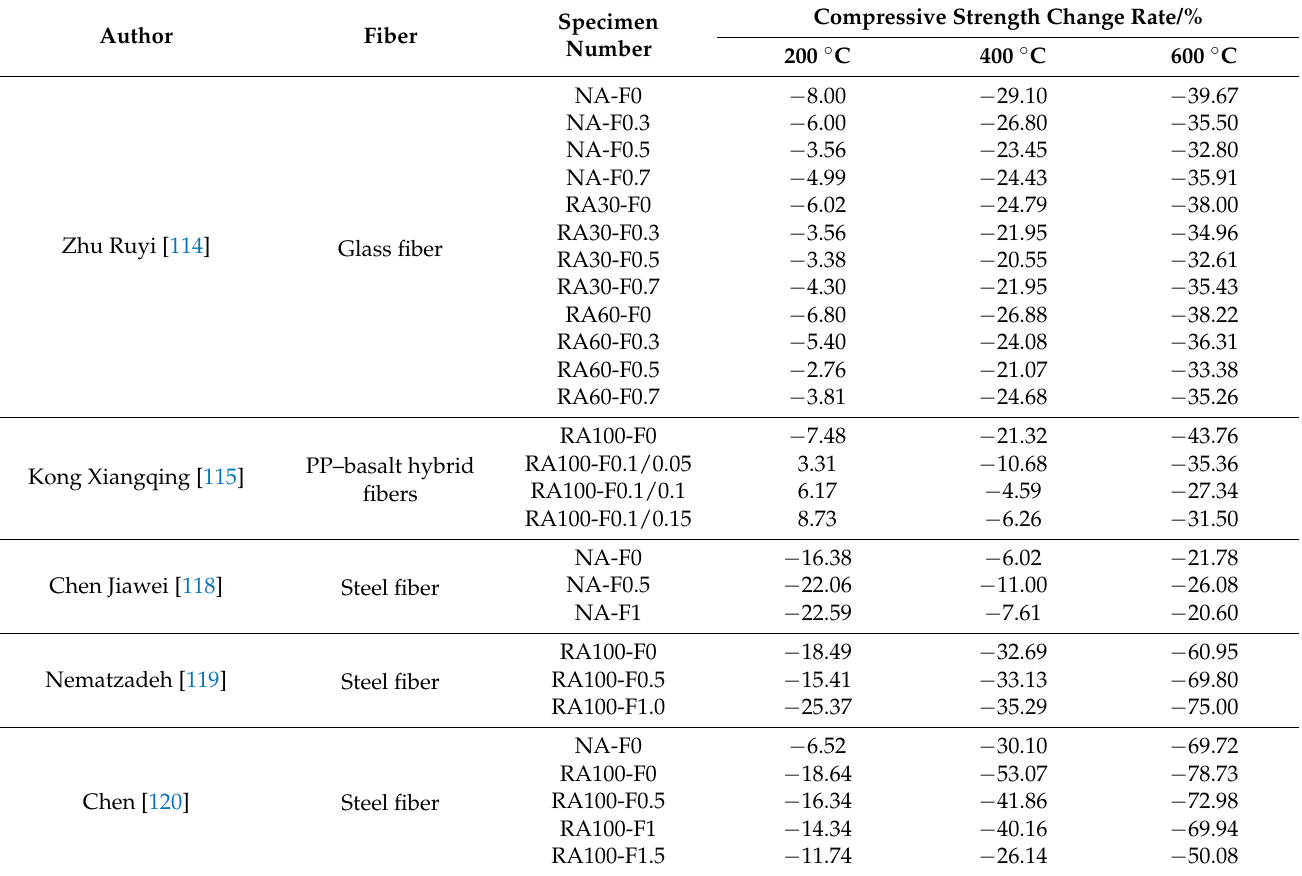
Table 3. Change rate of compressive strength of fiber RAC under high